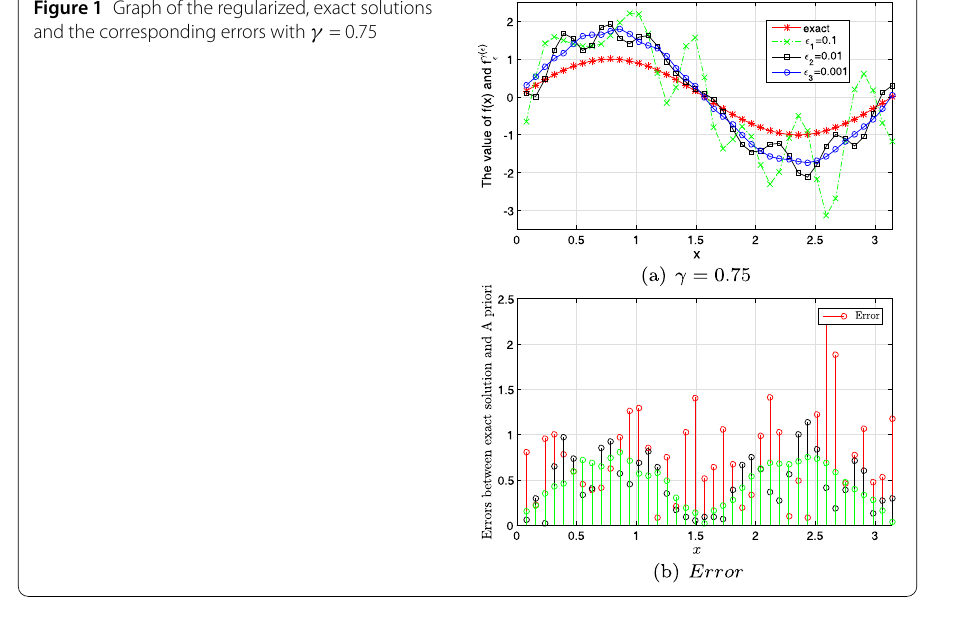
Figure 2 Graph of the regularized, exact solutions and the corresponding errors with γ =